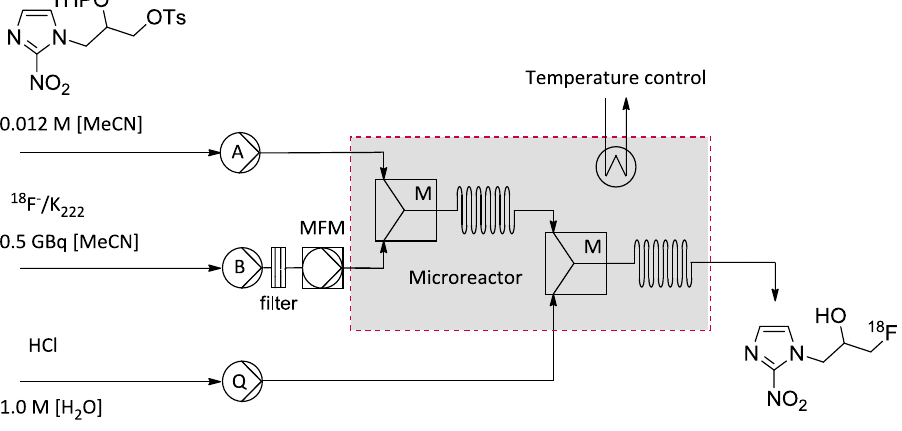
Figure 10. Schematic setup for the synthesis of a PET-tracer